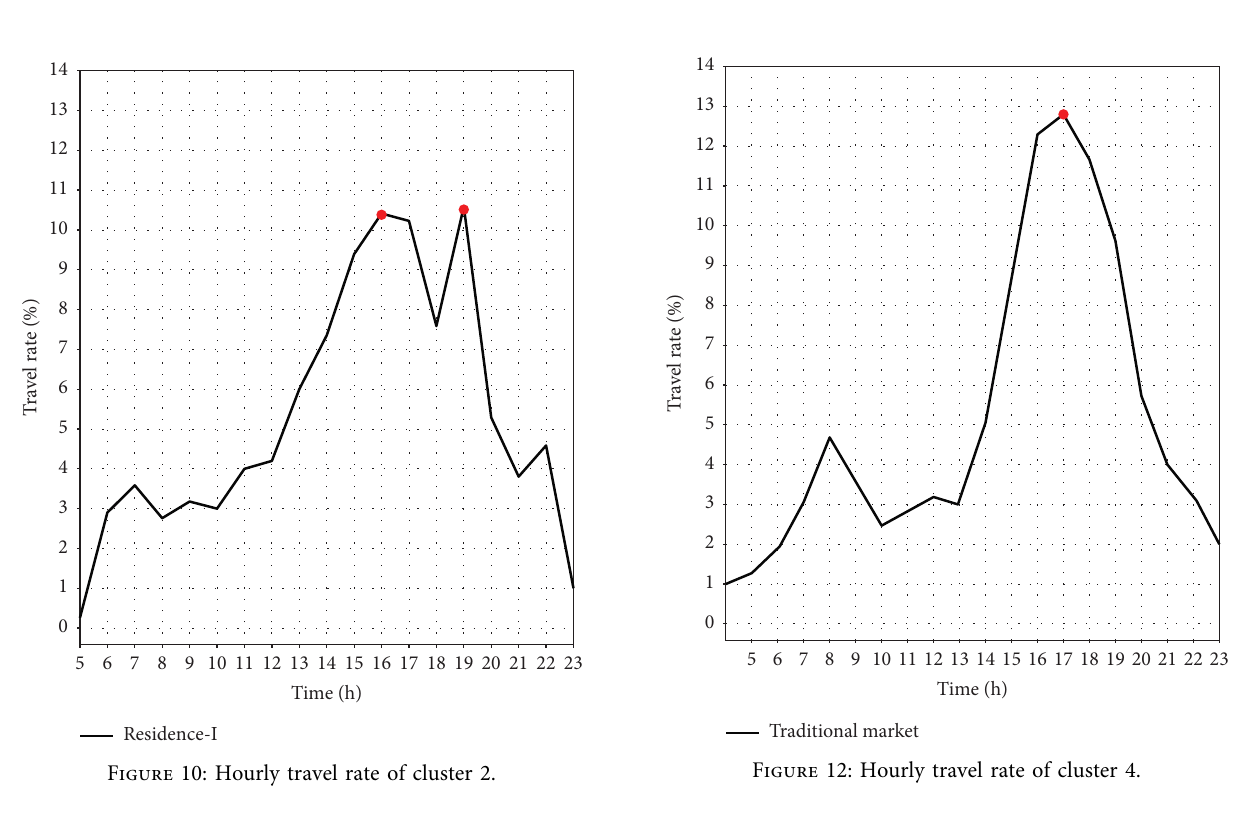
Figure 11: Hourly travel rate of cluster 3.